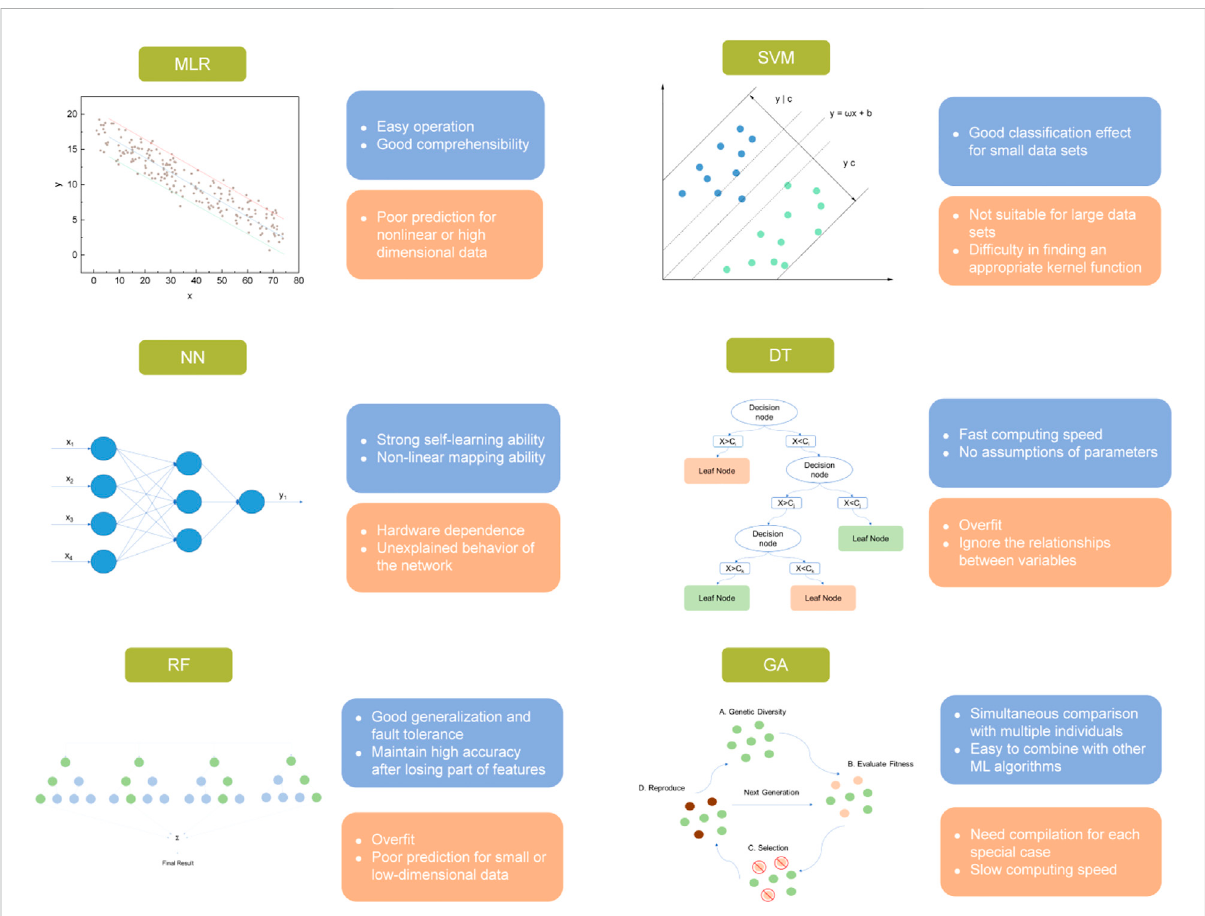
FIGURE 2 Primary ML algorithms used in CO 2 separation and their advantages (blue frame) and disadvantages (orange